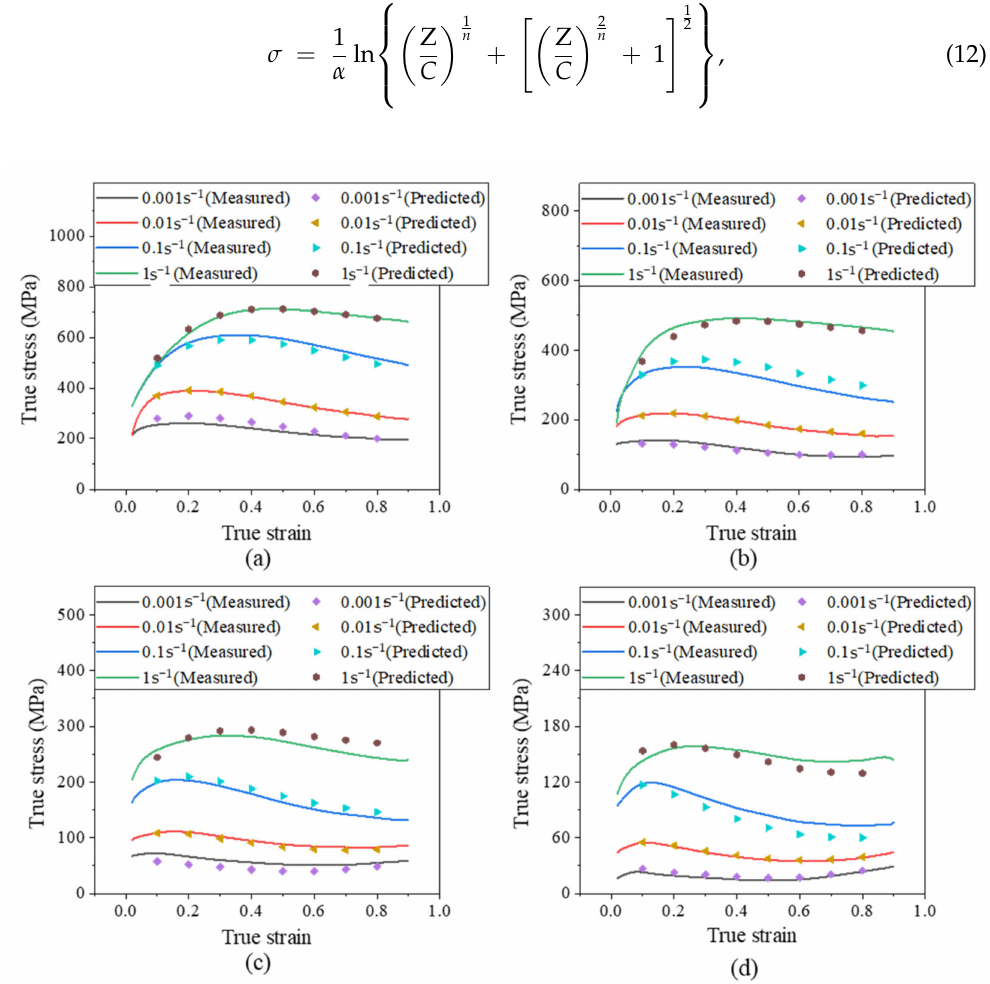
Figure 6. Experimental and predicted flow stress curves using the Arrhenius constitutive model